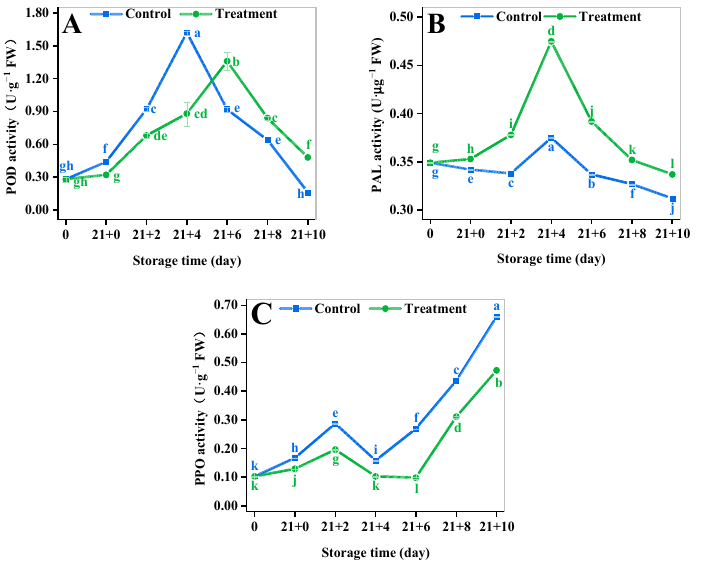
Figure 3. Effect of different storage methods on POD ( A ), PAL ( B ), and PPO ( C ) enzyme activities of yellow peach. Vertical bars represent standard deviations. Different letters represent statistical differences ( p < 0.05).